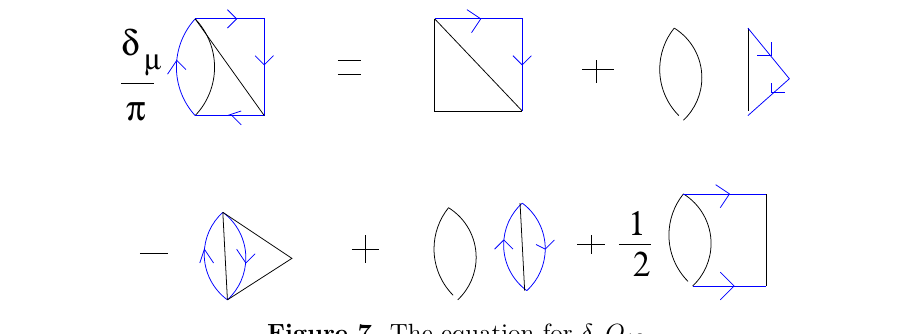
Figure 7 . The equation for (cid:14) (cid:22) Q 13 .